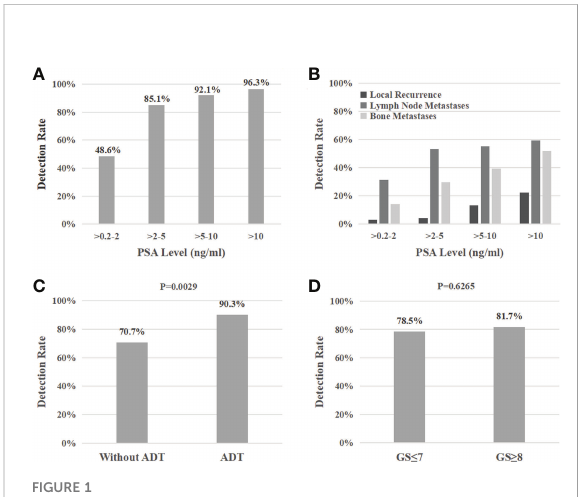
FIGURE 1 Detection rate of 99mTc-HYNIC-PSMA SPECT/CT based on PSA levels (A) , different recurrence regions (B) , androgen deprivation therapy (C) , and Gleason scores (D)